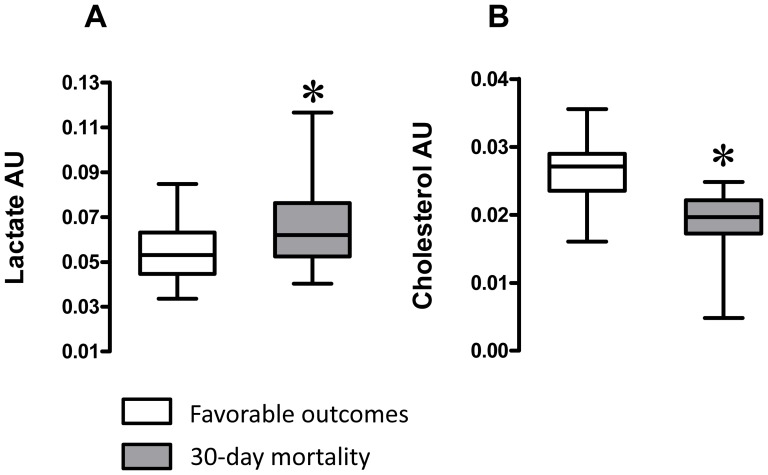

1H NMR signals intensities of lactate and cholesterol in plasmas.
(A) Contribution of a 1H NMR characteristic signal of lactate at 1.36 ppm to the spectrum of aqueous fraction of the plasma extract (Aq spectrum). (B) Contribution of a 1H NMR characteristic signal of cholesterol at 0.68 ppm to the spectrum of lipid fraction of the plasma extract (Org spectrum). Values are expressed as arbitrary unit (AU). Lines at the middle for medians, boxes extend from 25th to 75th percentile, error bars for max and min values. Boxes: white, plasma from patients with favorable outcome; grey plasma from patients with 30-day mortality outcome. * is for Student’s t test p <0.05.